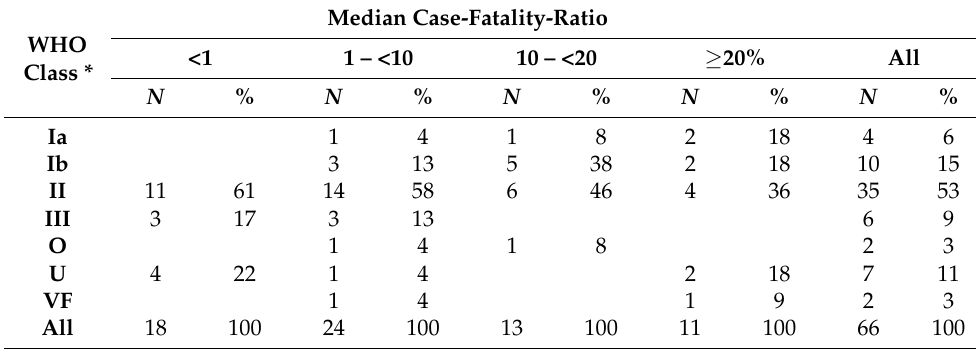
Table 3. Case fatality ratios for active pesticide ingredients by WHO